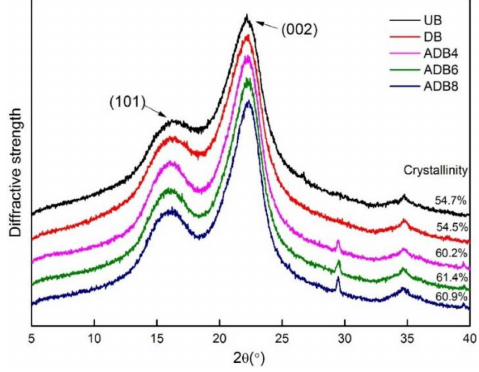
Figure 2. XRD analysis of treated and untreated